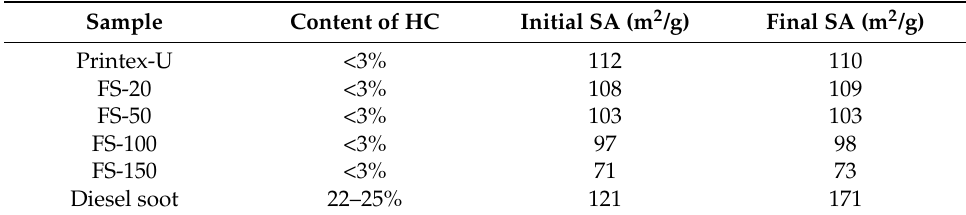
Table 4. Surface area of soots before and after hydrocarbon burnout.